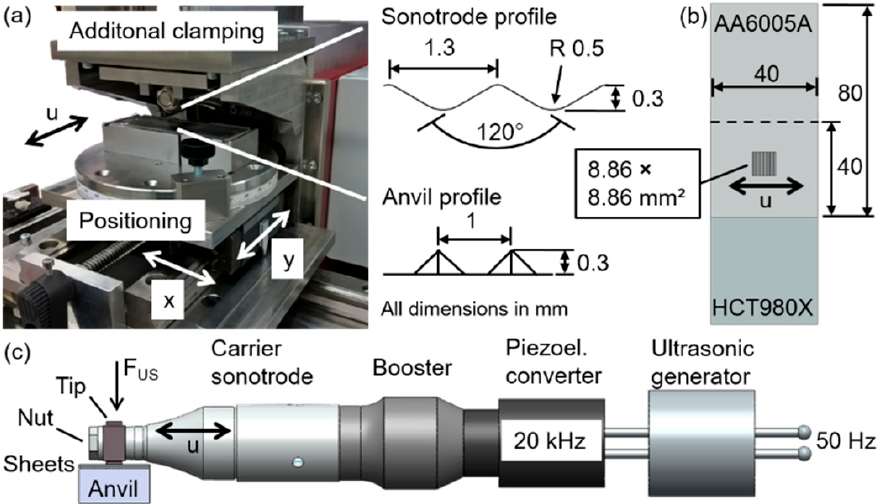
Figure 1. ( a ) Branson Ultraweld L20 with anvil; ( b ) geometry of overlapping specimens; and ( c ) schematic representation of main principle and setup, oscillation direction (u). All dimensions in mm. AA6005A was used as the upper sheet for all experiments, since this leads to less wear at the coupling surface compared to when steel is used on the tool side. The short cantilever length of the multi-part sonotrode limited the sample width to 40 mm, so that welding of spots exactly in the middle of the sample was enabled. Both sheets were 80 mm long (in rolling direction), the overlap length was 40 mm (marked by a dotted line in Figure 1b), resulting in a square overlap area of 40 × 40 mm 2 . Complex pre-treatments of the materials were avoided to emulate the testing conditions as close as possible to the application. The sheets were only wiped with ethanol prior to welding to ensure removal of dirt or grease. During specific welding tests, a Micro-Epsilon (Ortenburg, Germany) TIM infrared camera (32 frames per second) recorded the temperature profile at the edge of the interface between the sonotrode tip and the aluminum surface. As described by Patel et al. [14], tensile shear tests were performed at a constant speed of 1 mm/min in the air at room temperature using a ZwickRoell (Ulm, Germany) Z020 universal testing machine. The samples were prepared as described by Haddadi and Abu-Farha [19] and microscopically examined using the Zeiss (Oberkochen, Germany) Smartzoom 5 digital optical microscope and characterized in the Zeiss EVO 15 scanning electron microscope (SEM) equipped with energy-dispersive X-ray spectroscopy